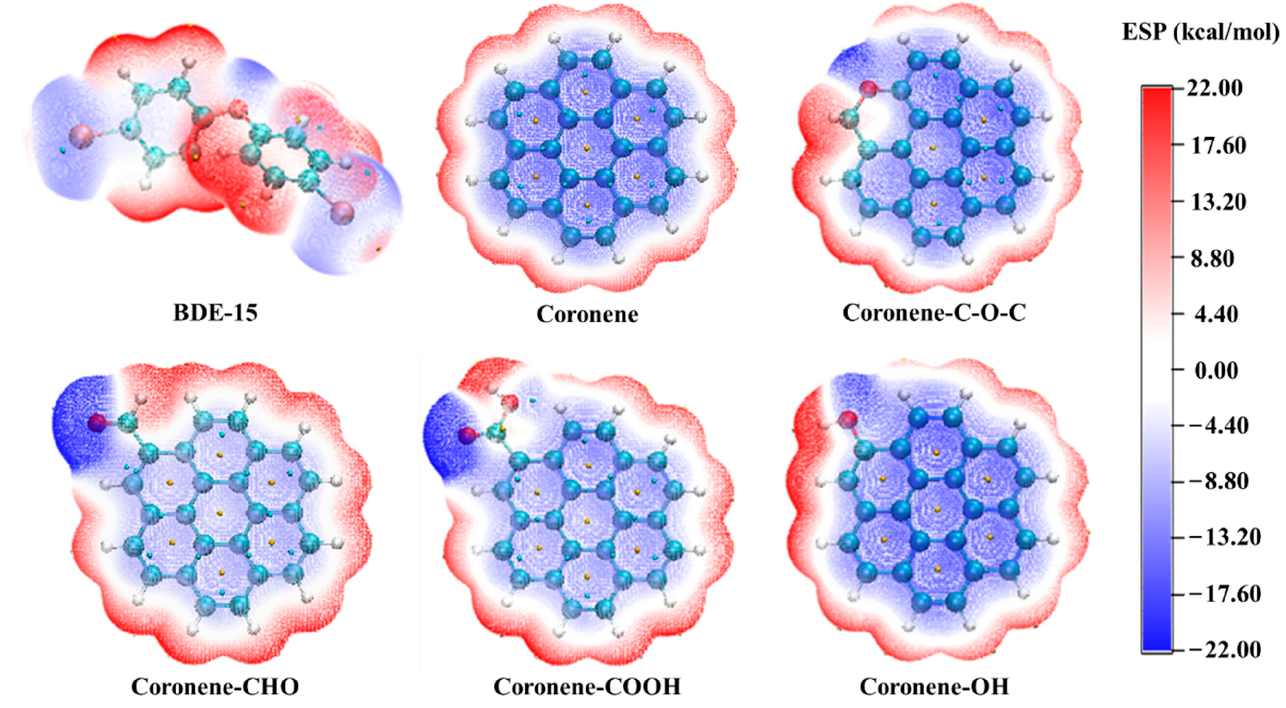
Figure 9. The ESP maps of BDE-15 and different struct GAC in aqueous solution.